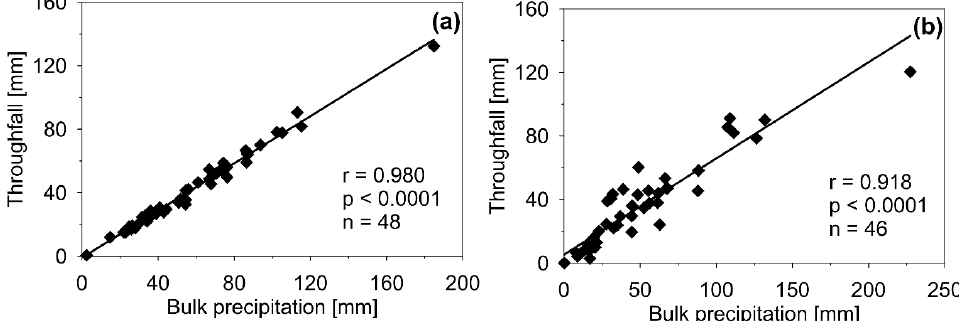
Figure 2. Linear correlations between bulk precipitation and throughfall in the Czarne ( a ) and in the Malik ( b ). r is the Pearson correlation coefficient, p is the significance value, n is the sample size. During the study period, the mean standard deviation of canopy interception was 28.7% ± 8.5% (Czarne) and 27.1% ± 24.7% (Malik). Extreme values ranged from 18.1% to 75.0% (Czarne) and from − 36.9% to 83.6% (Malik). In some instances, monthly throughfall for the Malik plot was observed as being higher than monthly precipitation in the Malik plot’s open area (canopy interception less than 0%). From 2010 to 2013, there were five such cases: in January and February 2010 ( − 31.5% and − 18.9%, respectively), in November 2011 ( − 35.3%), in August 2012 ( − 23.0%), and in April 2013 ( −